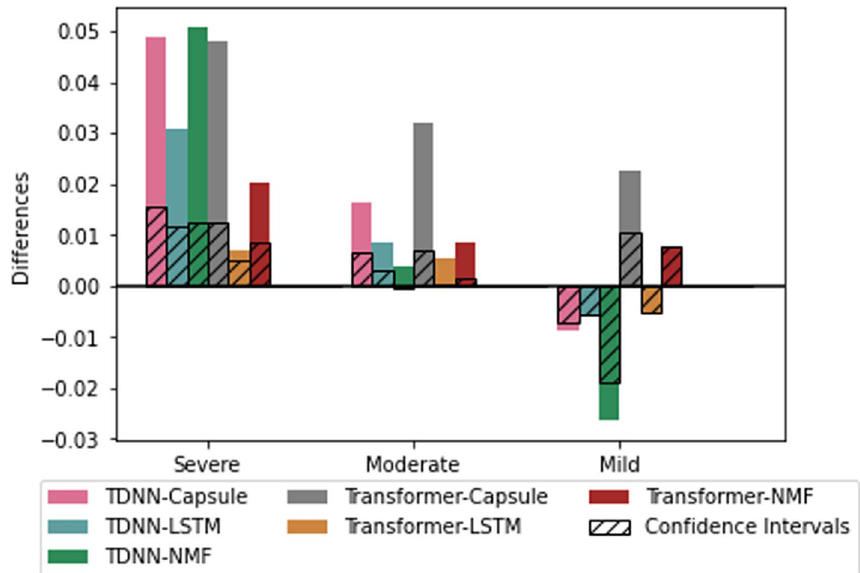
Fig. 11 Differences of acoustic models fine-tuned with and without dysarthria corpus in a setting of insufficient SLU task-specific training